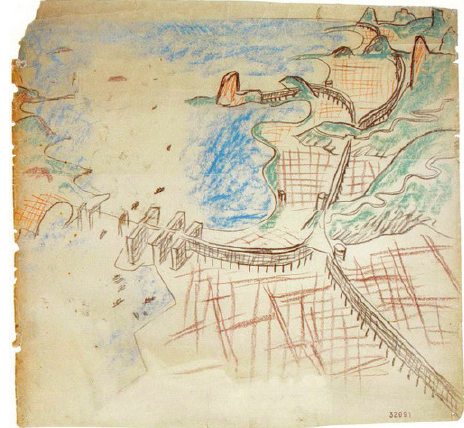
Fig. 4. Le Corbusier. Rio de Janeiro aerial view 1929, © FLC ADAGP